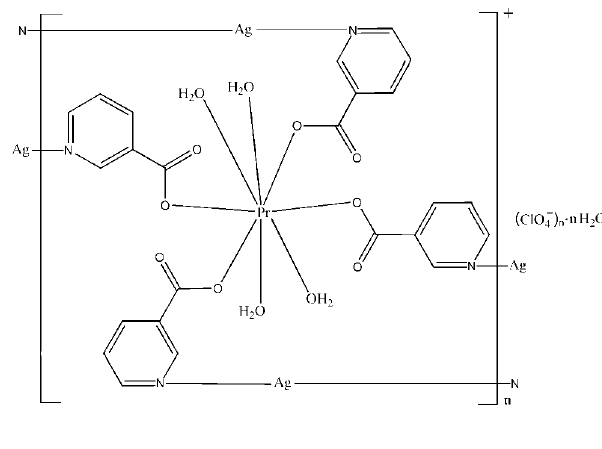
distorted square-antiprismatic coordination geometry, defined